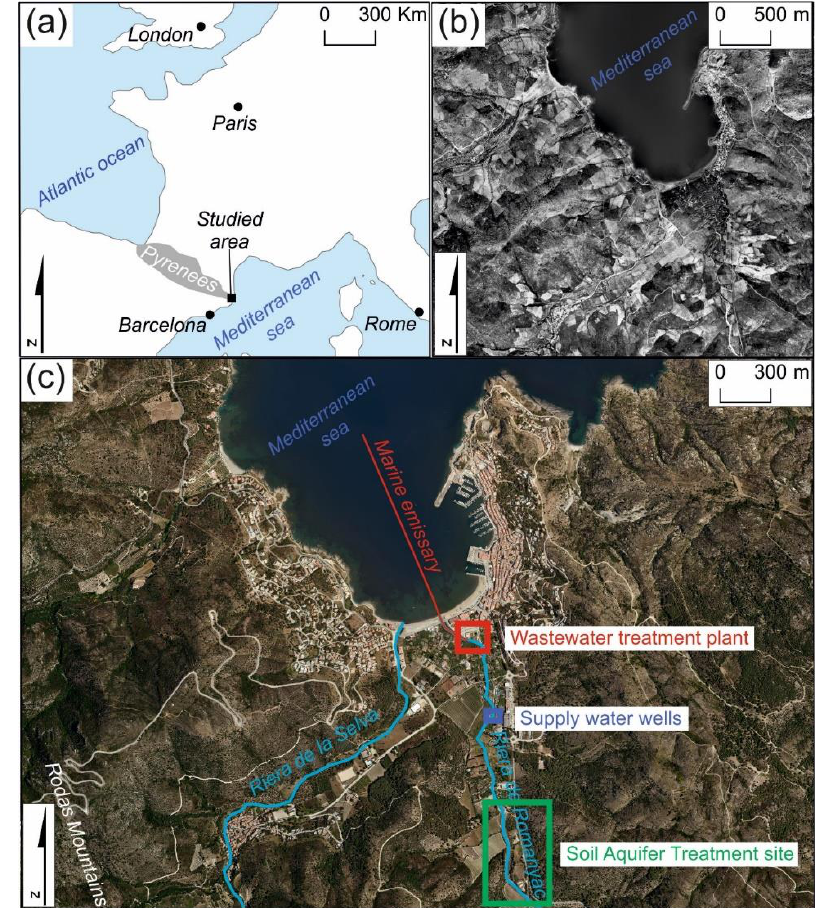
Figure 1. ( a ) Location sketch of the studied area; ( b ) landscape image of Port de la Selva (1956) showing the extensive agricultural use of soil in the 1950s compared to the current urbanization setting; ( c ) location of main hydrological features and water management facilities over current landscape image of Port de la Selva.